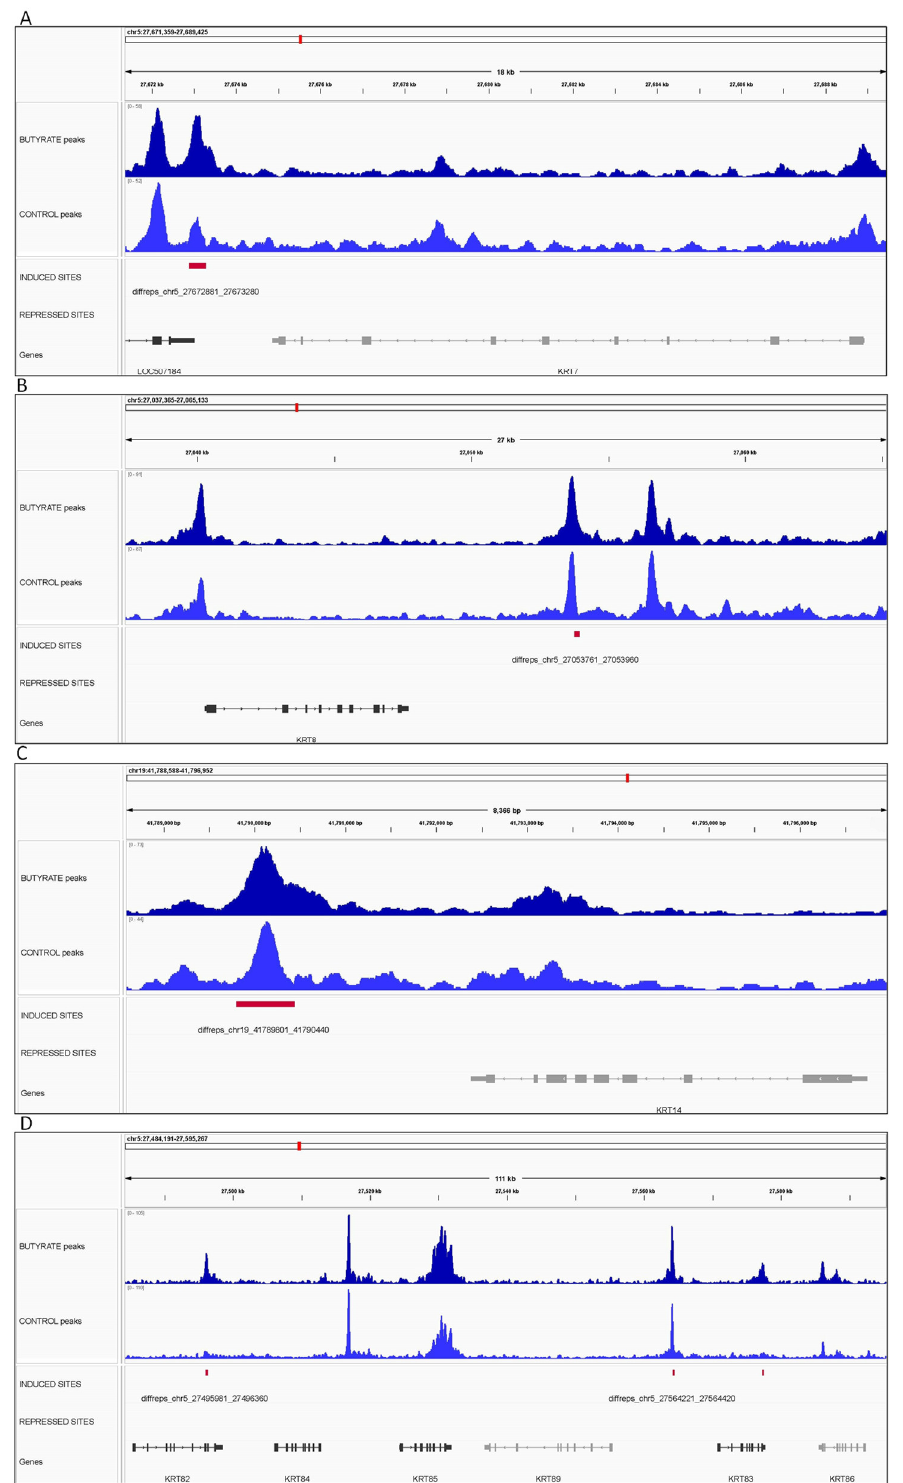
Figure 7. Integrative genomics viewer (IGV) screenshot of CTCF peaks (BT and CT) and the butyrate-induced and -repressed differentially CTCF-binding sites for keratin genes including—( A ) KRT7 , ( B ) KRT8 , ( C ) KRT14 , and ( D ) KRT82 , KRT83, KRT84, KRT85, KRT86 , and KRT89 genes. The X -axis represents the chromosomal location with the size bar given in kb.